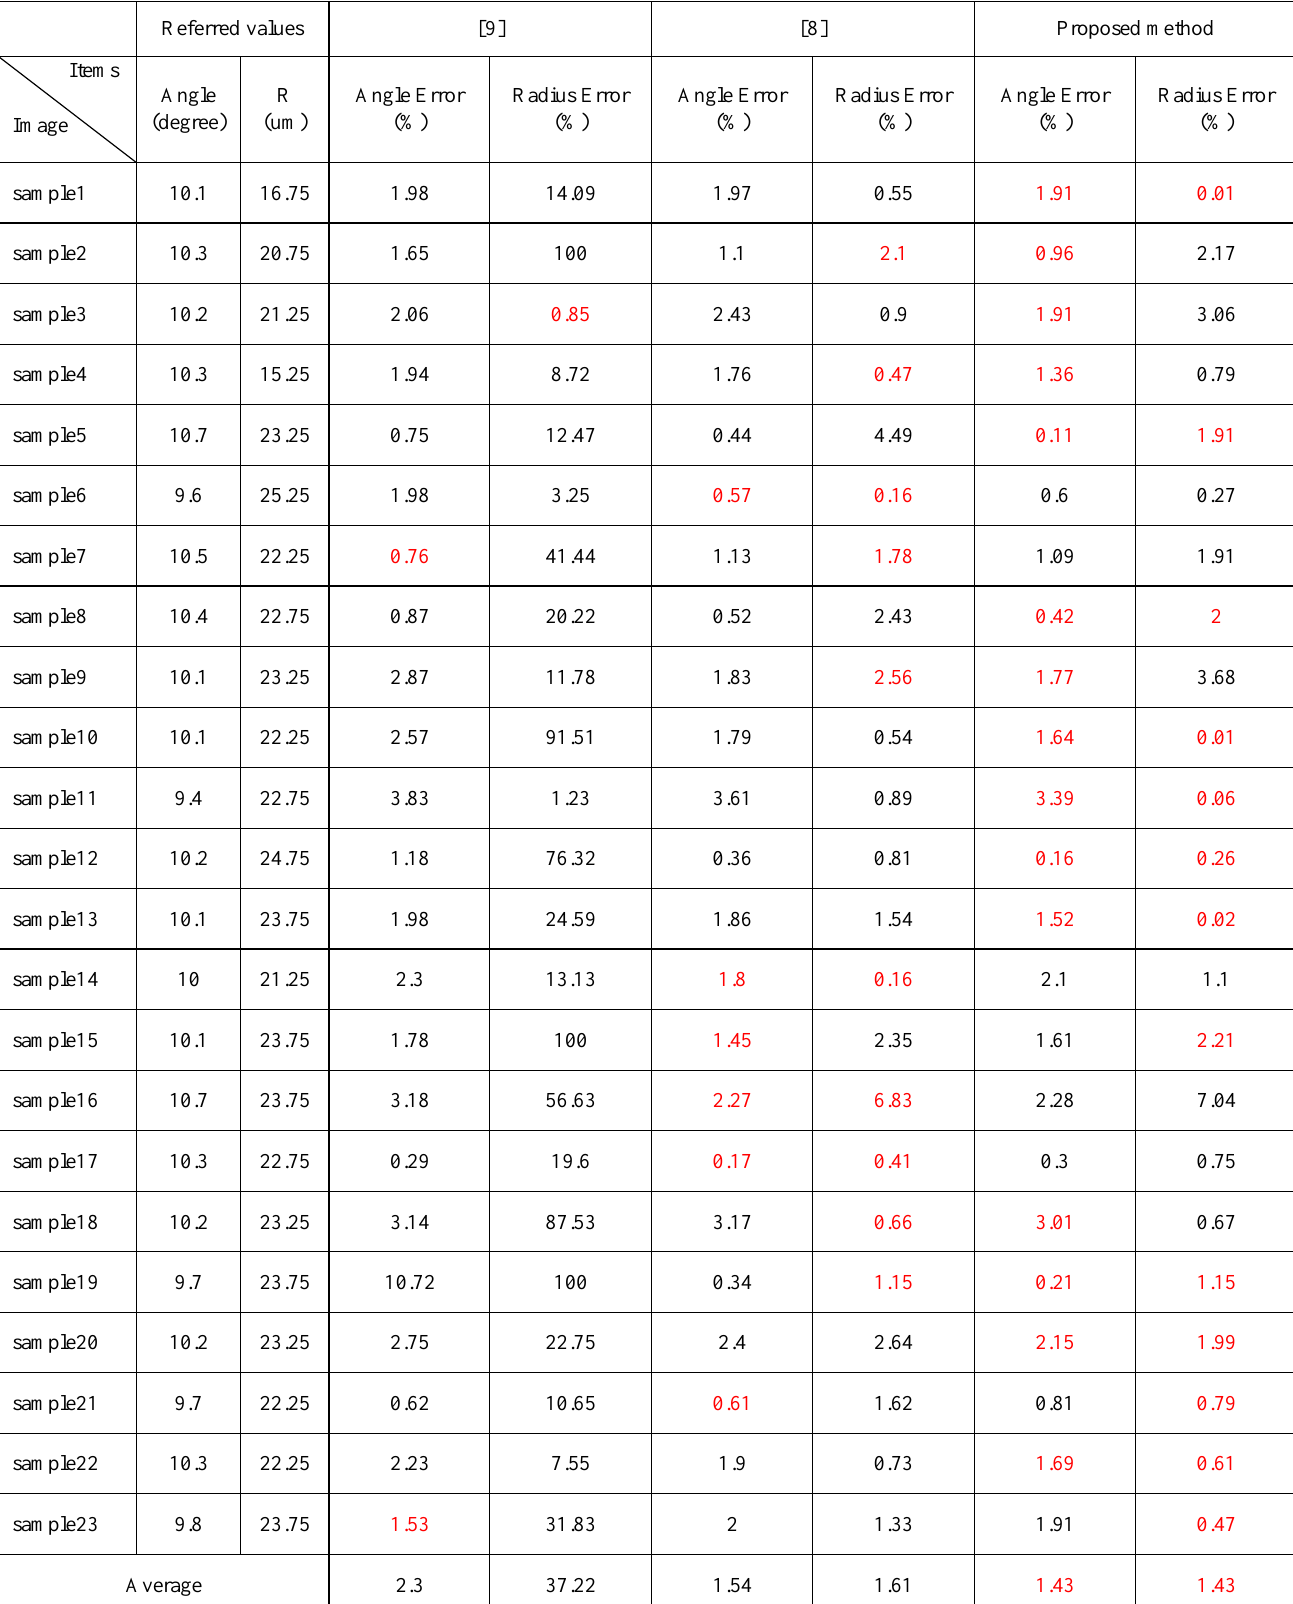
Table 1 Experimental results of different sub-pixel edge detection